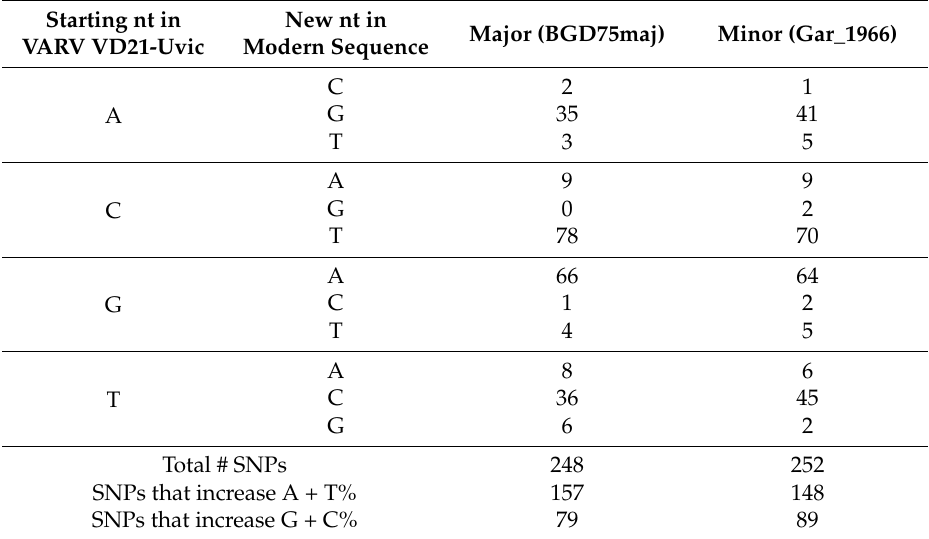
Table 2. Nucleotide changes for SNPs in modern VARVs compared to VD21-uvic. Starting nt in New nt in VARV VD21-Uvic